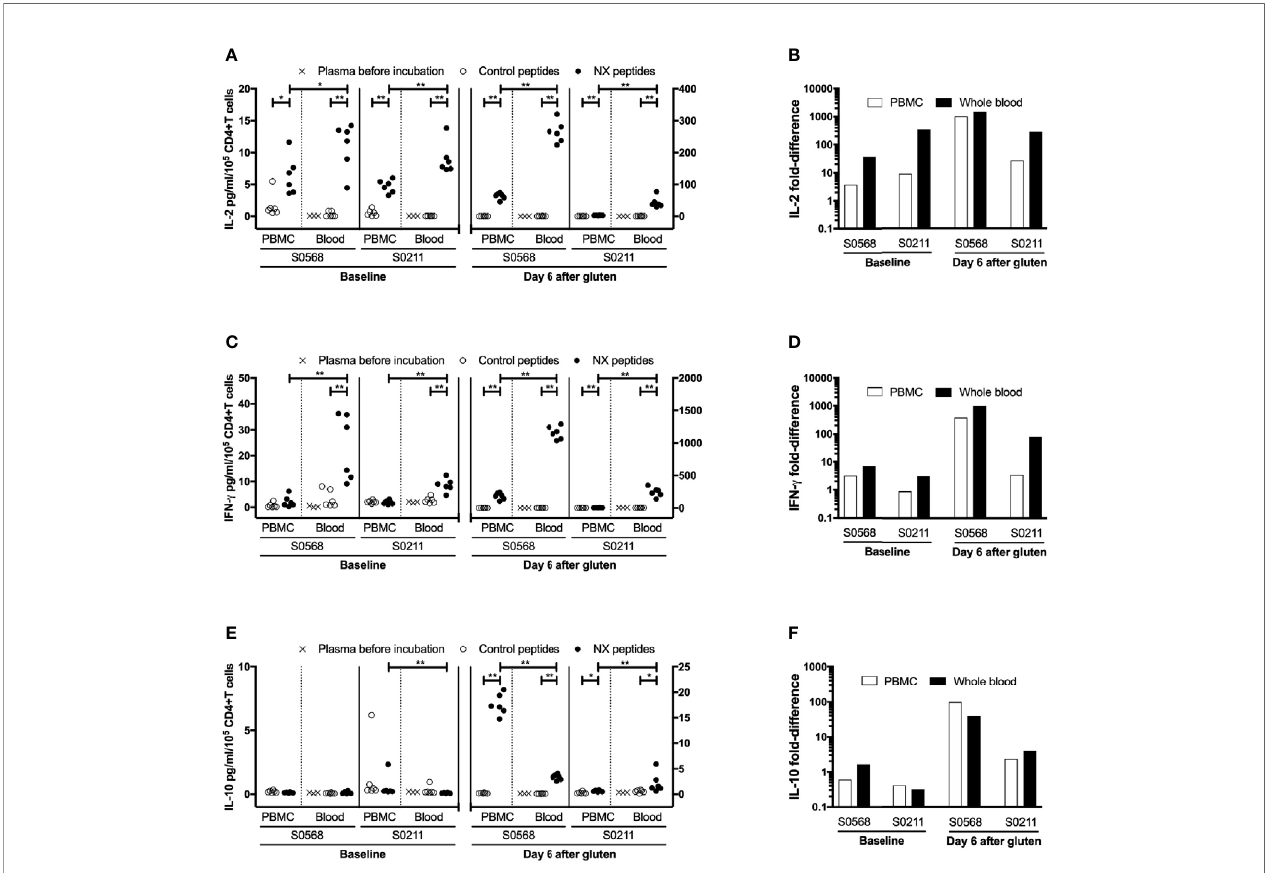
FIGURE 4 | Concentration and fold-difference relative to control for Nexvax2 (NX)-stimulated IL-2 (A , B) , IFN- g (C , D) and IL-10 (E , F) release in PBMC and whole blood normalised for the number of live CD3+CD4+ T cells. Unseparated blood was allowed to stand at room temperature while PBMC were separated from a matched sample. Three hours after blood was collected, 225 m l aliquots of whole blood or 0.5 million PBMC in media were dispensed into microwells containing 25 ul PBS and test antigen. Plasma or media were separated after 24-hour incubation. For whole blood incubations, cytokine concentrations in plasma separated from whole blood before incubation with NX or control is also shown. Data points represent cytokine levels for each of six replicates assessed for each condition with blood collected before and six days after commencing gluten challenge for two coeliac disease patients. Mann-Whitney U test was used to compare NX-stimulated cytokine release in PBMC versus fresh whole blood; statistical signi fi cance is indicated by *p < 0.05, or **p <